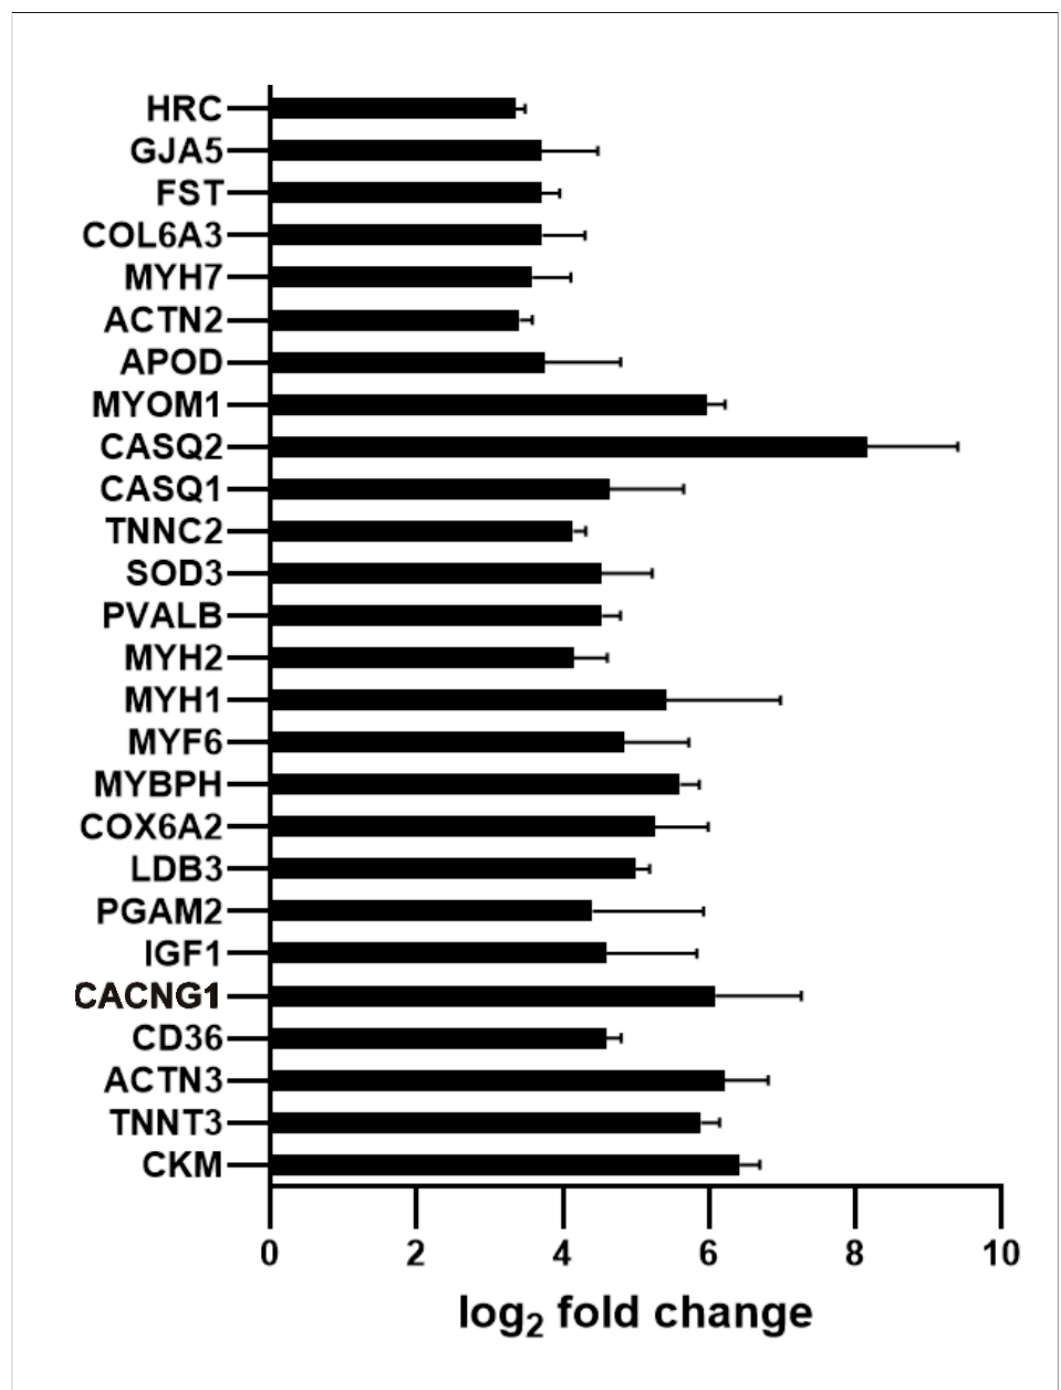
Figure 6. Expression of genes involved in myogenesis in PMA-treated MO3.13 cells; 26 genes with fold change ≥ |10| are shown.